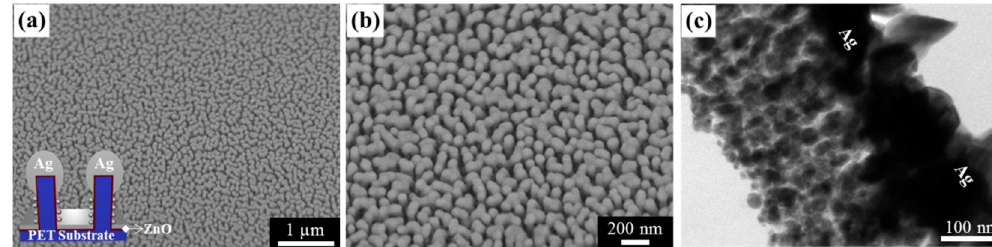
Figure 2. Fabrication of mechanically reinforced Ag nanostructures deposited onto soft polymer nanopillars. ( a , b ) SEM images of Ag nanostructures deposited onto ZnO / PET nanopillars. The inset shows a schematic cross-sectional structure of the mechanically reinforced Ag nanostructures. An 8.4-nm-thick ZnO thin film was conformally deposited by atomic layer deposition onto the plasma-treated PET nanopillars. The PET nanopillars had the same aspect ratios as the nanopillars used to assemble the capillary-induced leaning structures. ( c ) Cross-sectional TEM images of the Ag nanostructures after applying DI water. The mechanically reinforced Ag nanostructures stood upright, even after applying capillary forces, due to the deposition of a thin rigid ZnO layer. The TEM image suggests that Ag was grown under a wetting mode on the ZnO surface.